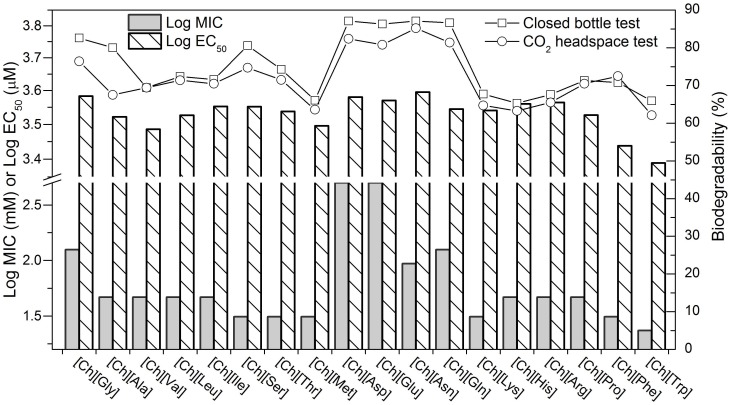
The correlation between toxicity toward AChE (log EC50) and E. coli (log MIC) and biodegradability.